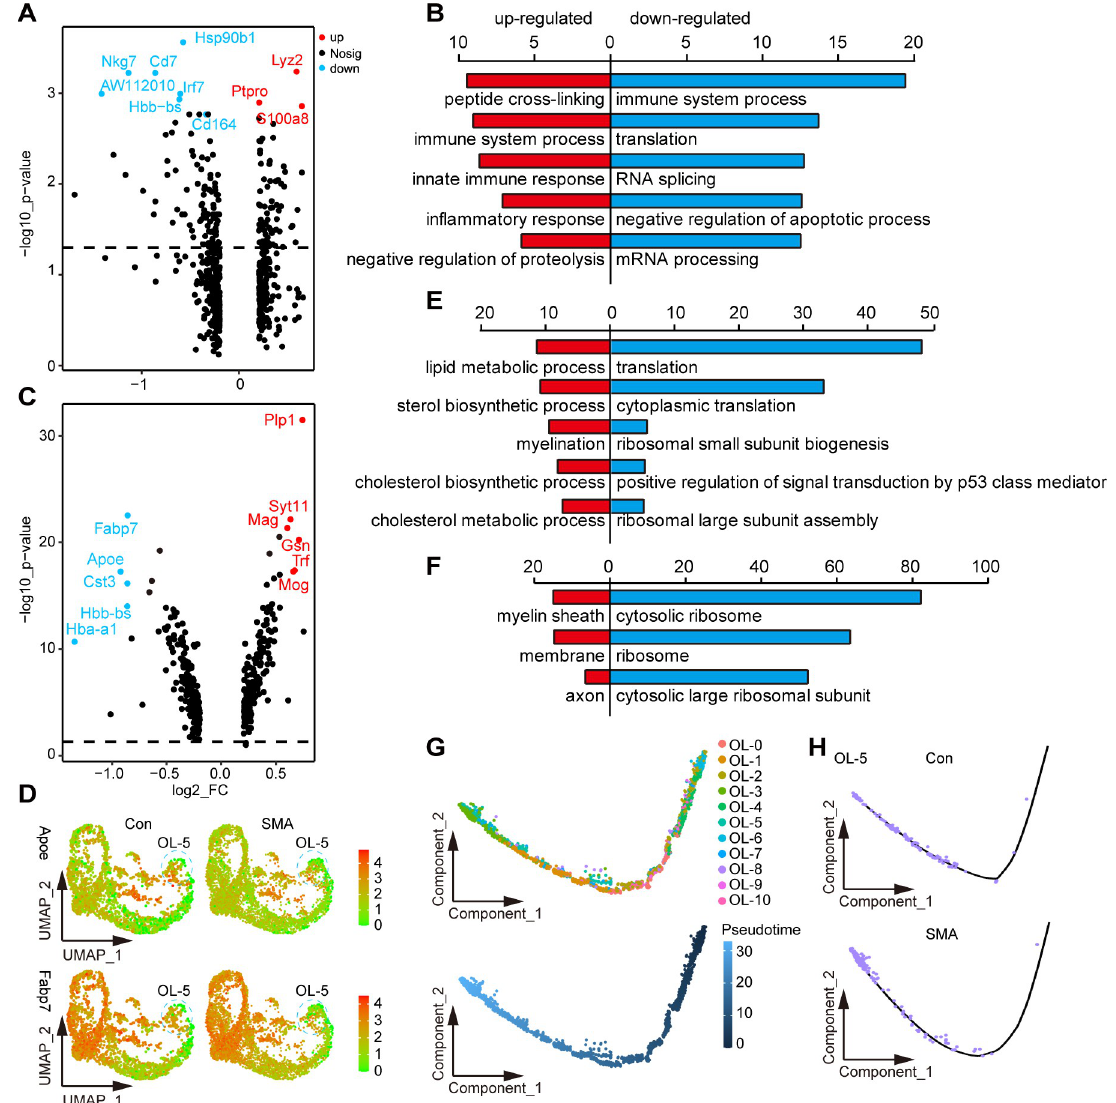
Fig 5. Altered gene expression of glial cell subtypes in the SMA spinal cord. (A) Volcano plot of DEGs in MG-5 subpopulations. (B) BP analysis of DEGs in MG-5 subtypes; the top 5 most significant terms are shown: red indicates upregulated terms, and blue indicates downregulated terms. (C) Volcano plot of DEGs in OL-5 subpopulations. (D) Signature DEGs expression of OL-5. (E, F) BP and cellular component analysis of DEGs in OL-5; the top 5 most significant terms are shown. (G) The position of each subtype of OL lineage on the pseudo time trajectory maturing from right to left. (H) Pseudo time trajectory of OL-5 in SMA and control mice.